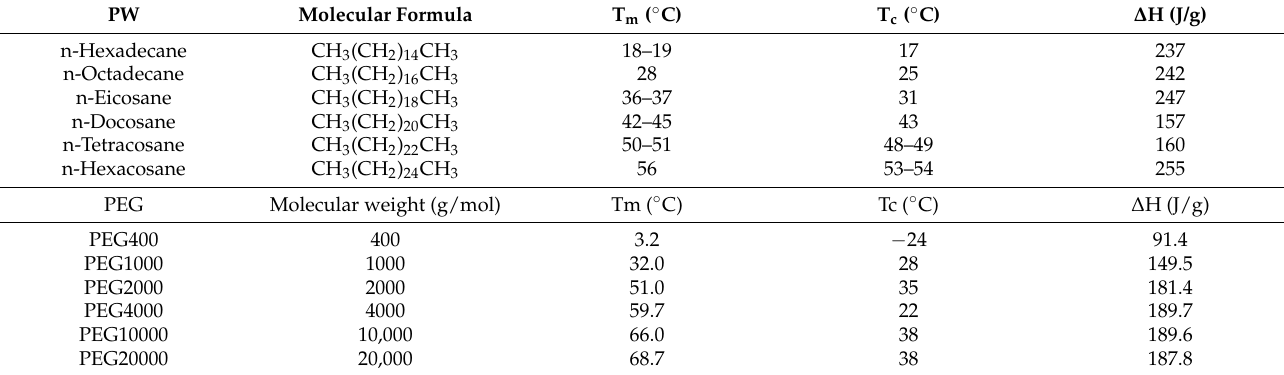
Table 3. The thermophysical properties of commonly used organic solid–liquid PCM